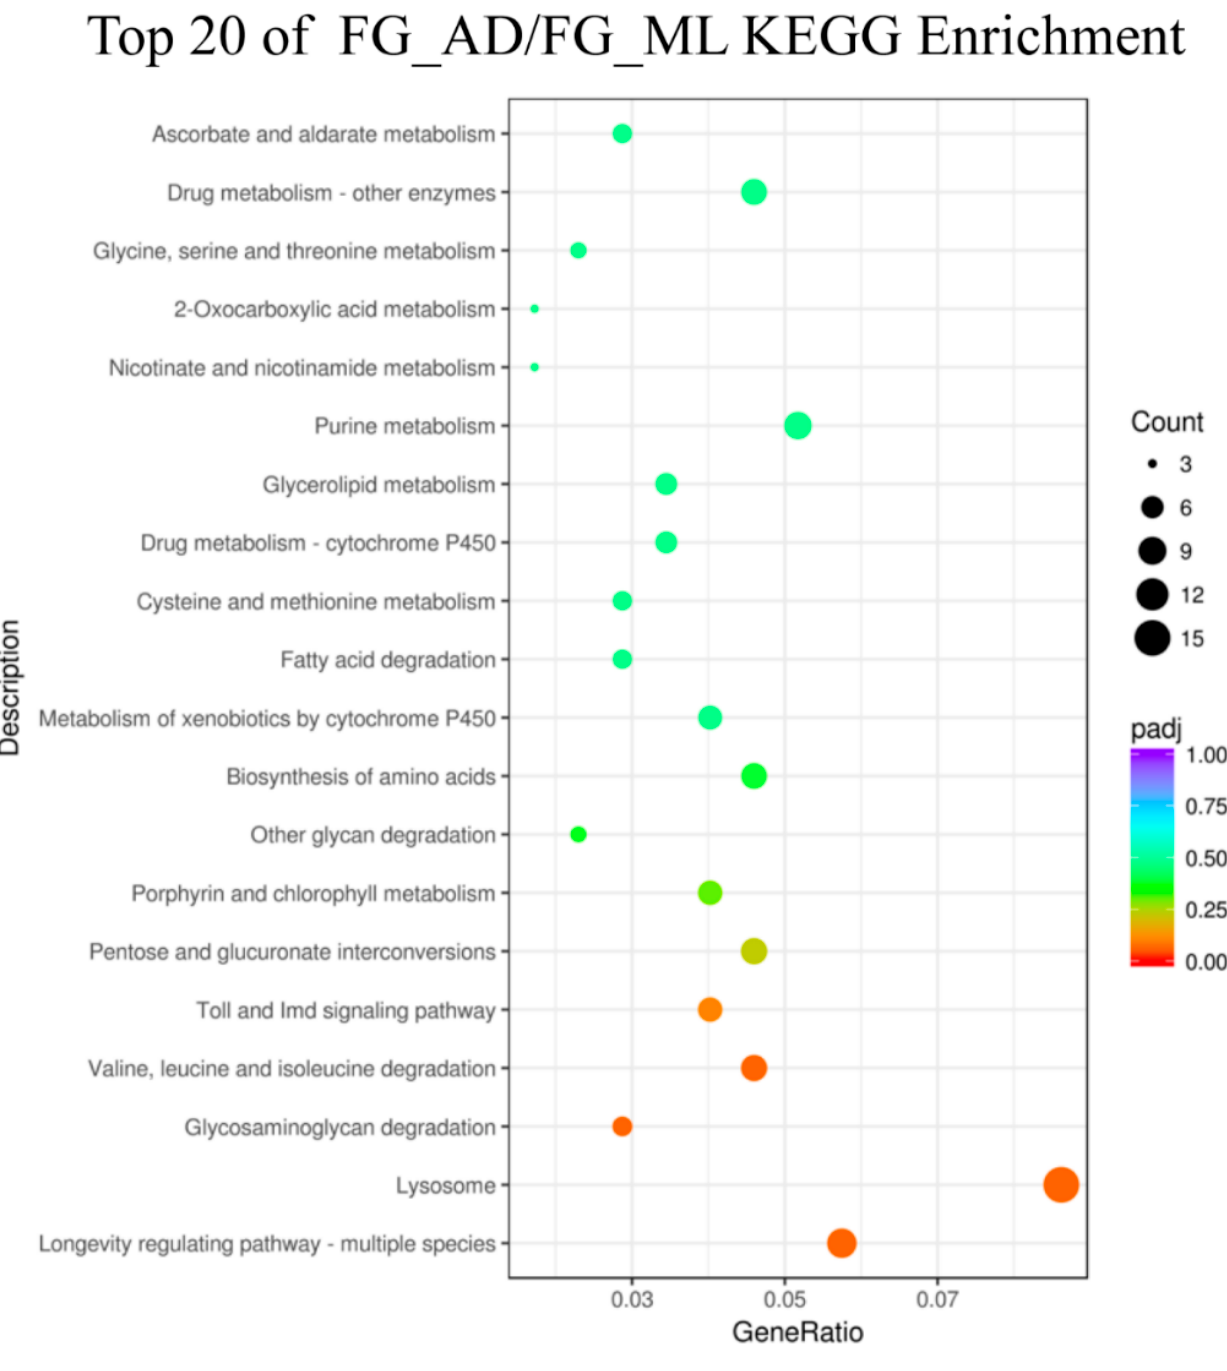
Figure 8. KEGG enrichment of FG_ADvsFG_ML. Statistics of top 20 pathway enrichment of differ- entially expressed genes in each pairwise. Padj is ranging from 0 to 1, and less value means greater intensiveness. The size of the plot represents the number of DEGs involved in the relevant pathway.